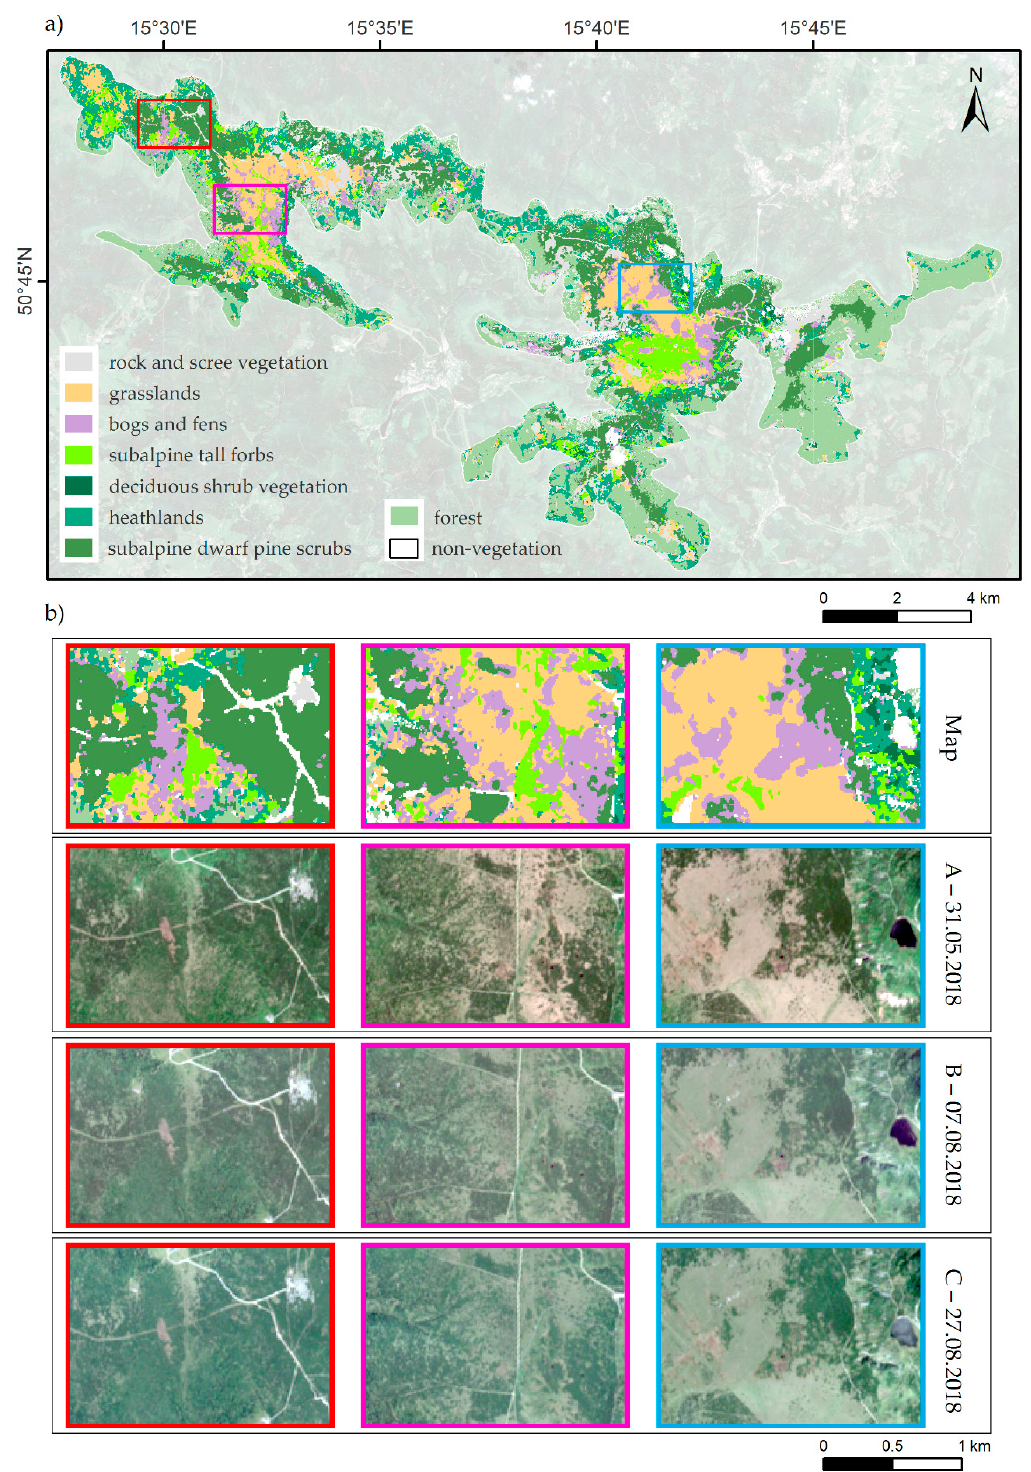
Figure 6. Map of vegetation types of the Giant Mountains; basemap: Sentinel-2 image in natural red, green, blue (RGB) composition, acquired on 31 May 2018 ( a ); enlarged parts of the map and Sentinel-2 images in natural red, green, blue (RGB) compositions that make up the ABC dataset ( b ).